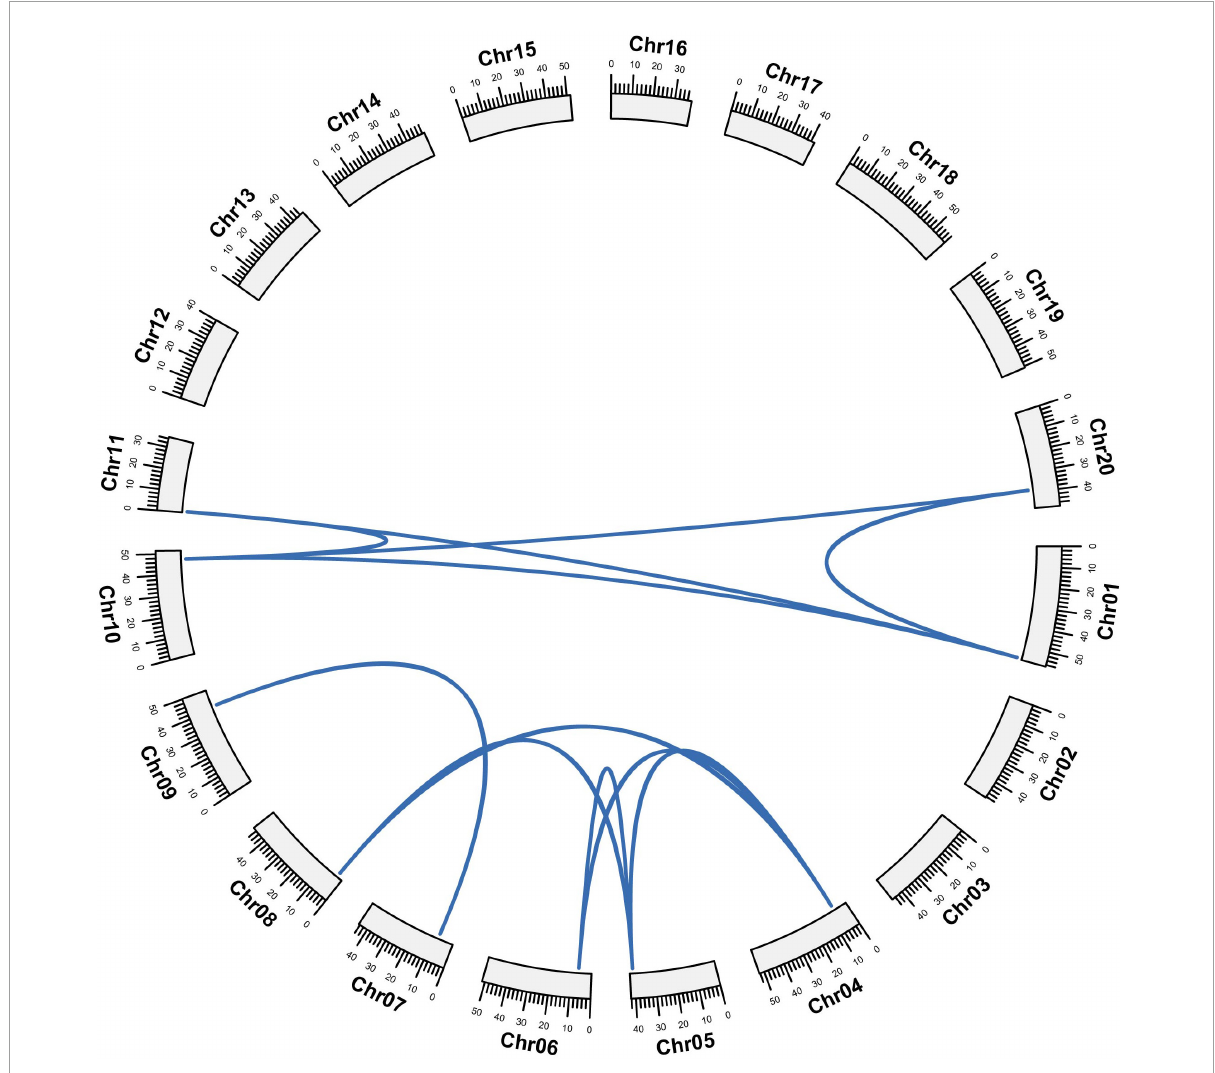
FIGURE5 Gene duplication and synteny analysis. Gene duplication among GmCPP genes. Blue line shows orthologous/paralogous pair. Gm01 to Gm20 shows the chromosomes of Glycine max